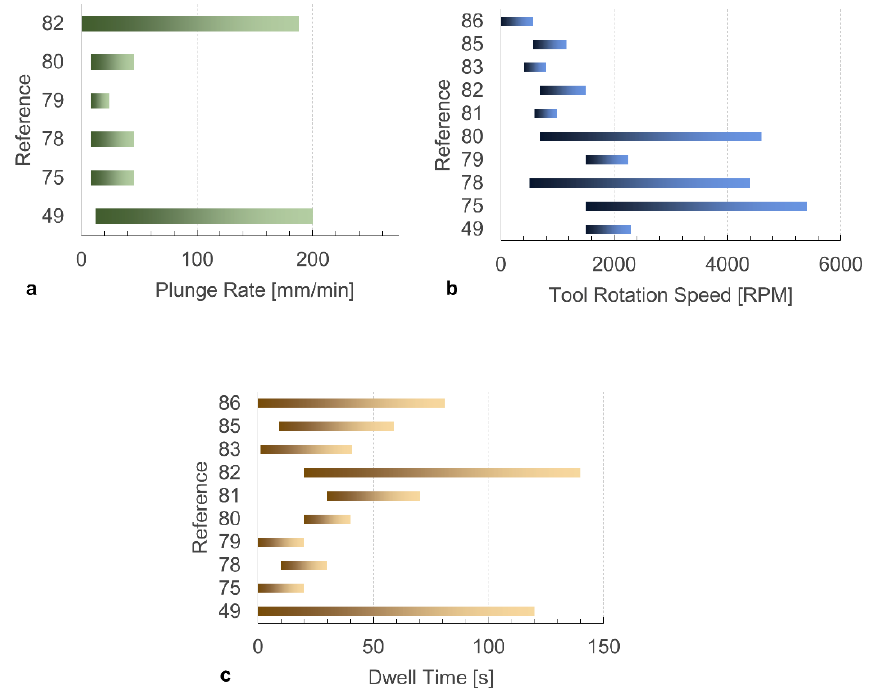
Figure 31. Processing windows analyzed in different papers concerning FSSW of polymers. Effect of ( a ) plunge rate; ( b ) tool rotation speed and ( c ) dwell time.